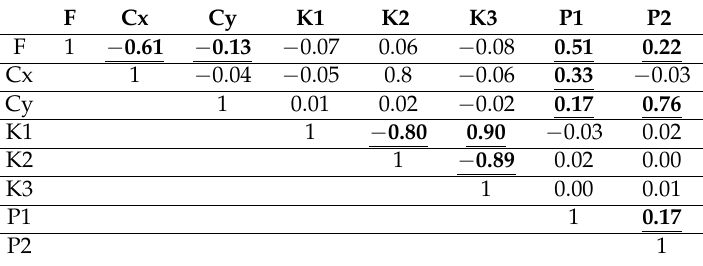
Table 4. Correlation between the camera